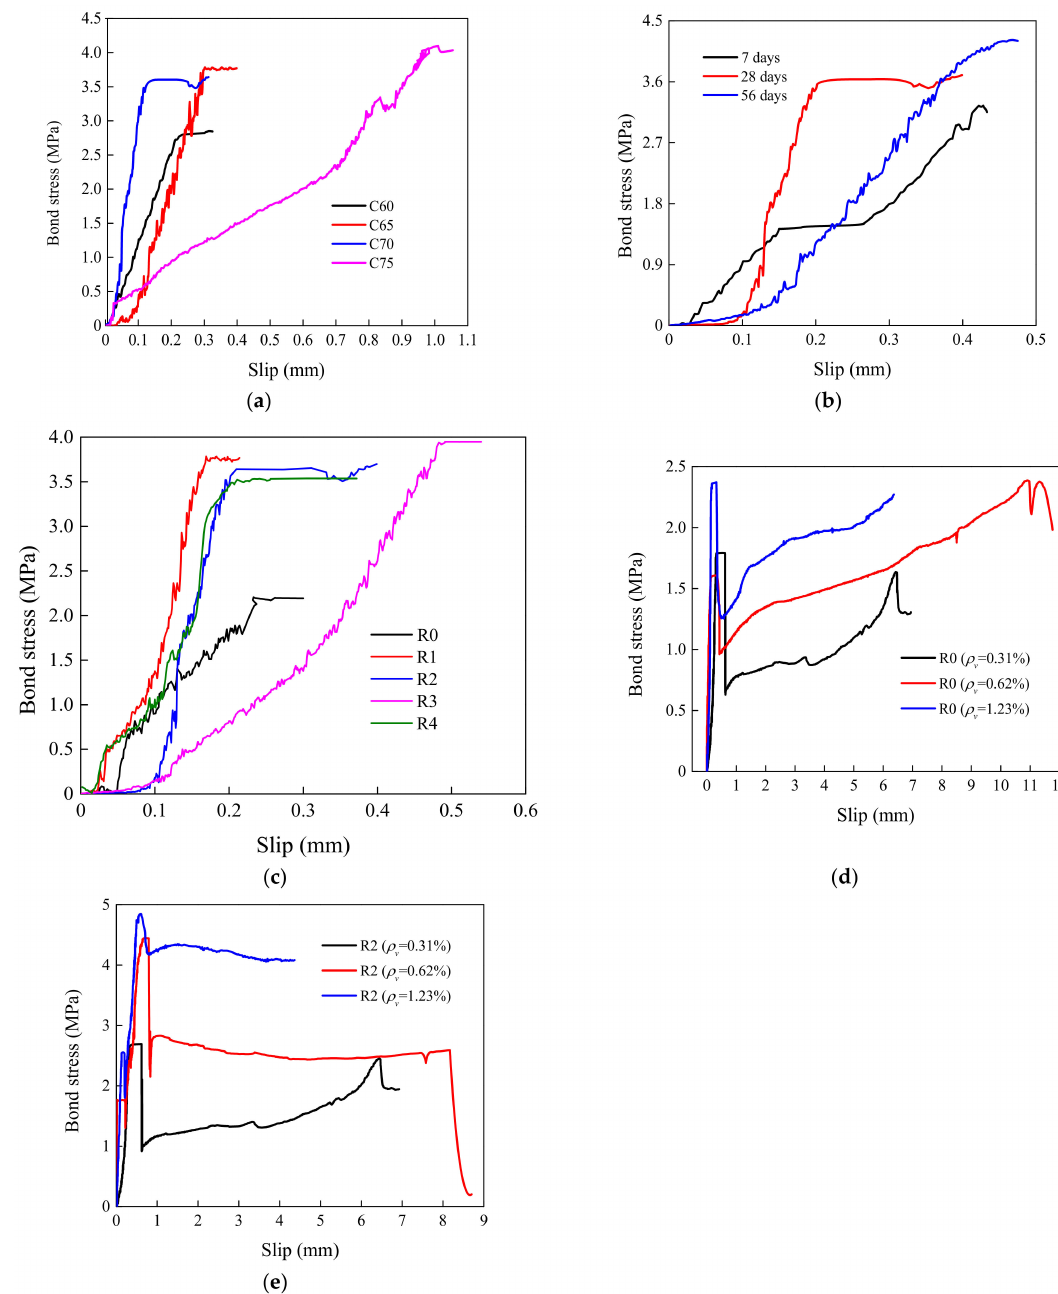
Figure 13. Bond stress–slip curves of the specimens. ( a ) Compressive strength; ( b ) curing age; ( c ) surface roughness; ( d ) specimens with steel shear dowels (R0); ( e ) specimens with steel shear dowels